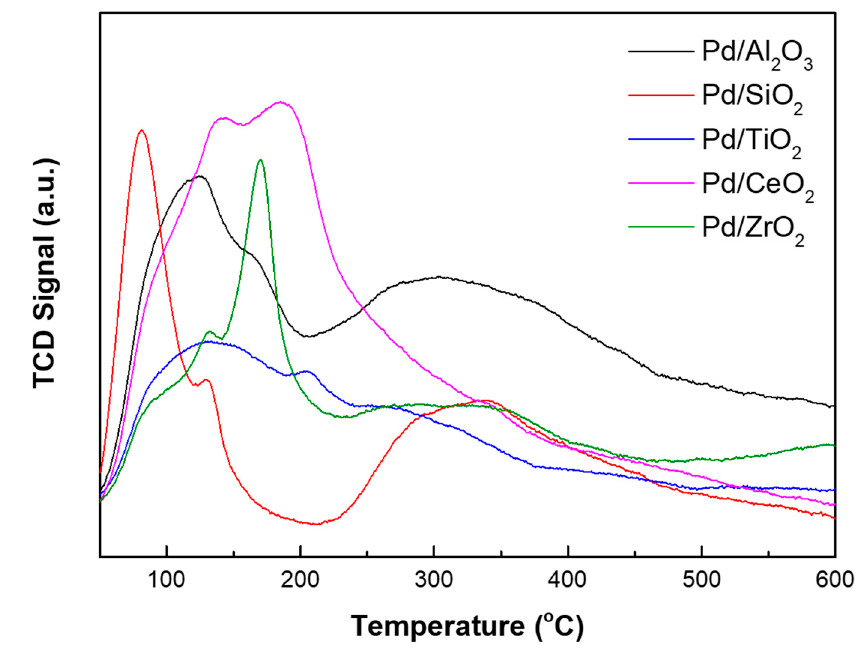
Figure 5. NH 3 -TPD profiles of Pd catalysts.